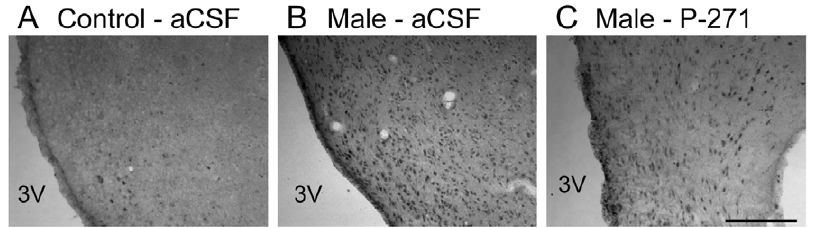
Figure 2. Fos induction in the rostral ARC following male exposure. Representative bright-field photomicrographs showing greater Fos immuno-localization in anestrous ewes exposed to males, with or without kisspeptin antagonist treatment (Male - aCSF, Male - P-271), compared to ewes not exposed to males (Control – aCSF). 3V, Third ventricle. Scale bar , 200 m m.